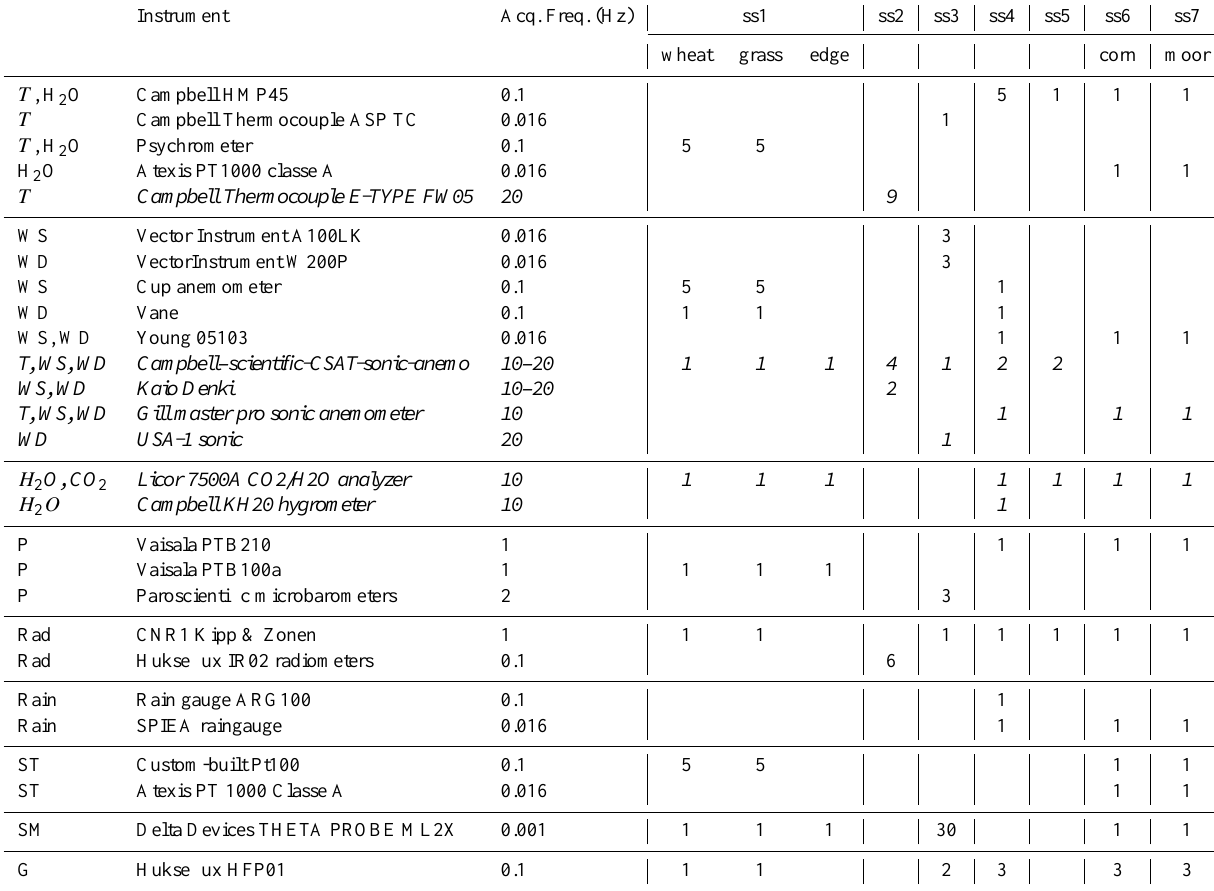
Table A2. List of the variables measured at the surface sites (first column), instruments used (second column) and their acquisition frequency (third column). The abbreviation for the measured variables are T : temperature, WS: wind speed, WD: wind direction, H 2 O: humidity, CO 2 : carbon dioxide concentration, P: pressure, Rad: radiative budget terms, ST: soil temperature, SM: soil moisture, G: ground heat flux. For each surface station, the number of specific instruments installed is indicated (columns 4 to 12). Note that the lines in italic correspond to high frequency